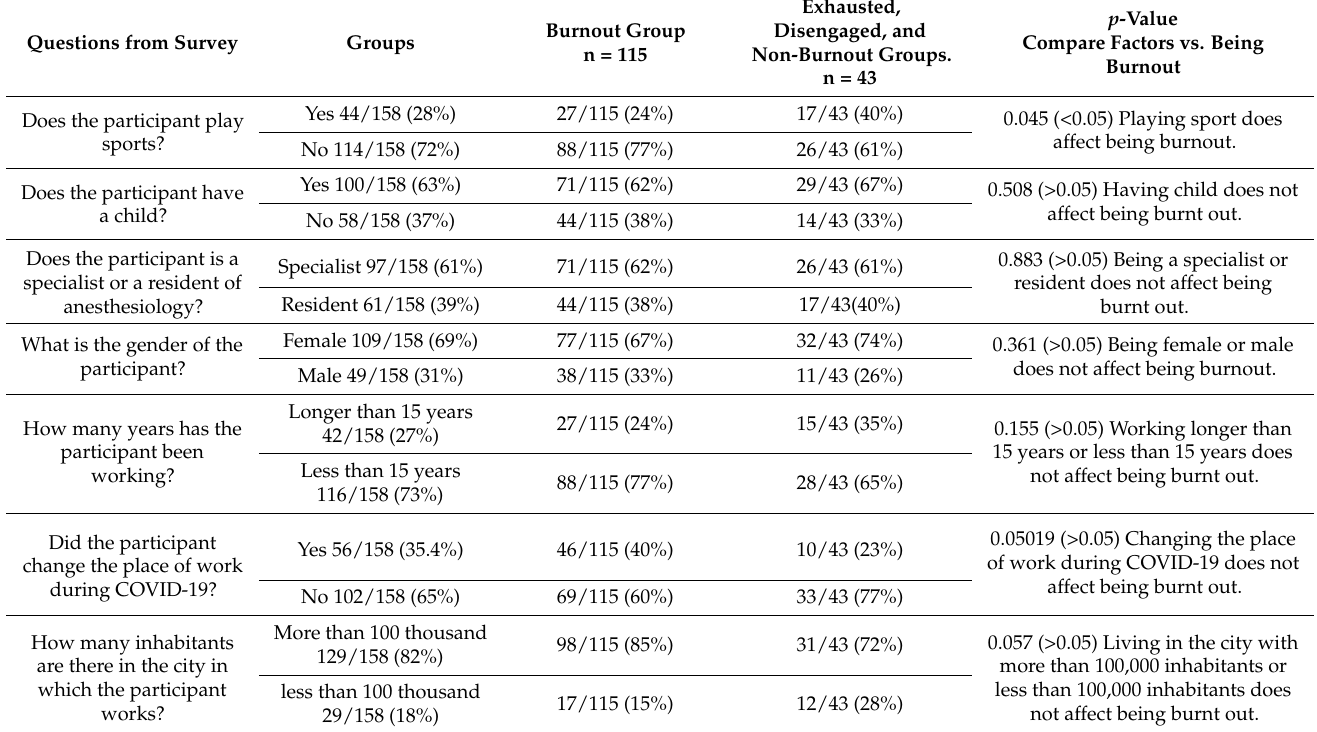
Table 2. Summary descriptive table compares the proportions of burnout vs. non-burnout accord- ing to the given questions . p -values were measured using a chi-square test. We measured whether factors, from the questions asked, statistically influenced being burned out in an anesthesiologist’s job. We considered whether playing sports, having a child, being a specialist or a resident, being a female or a male, the number of working hours, working less or more than 15 years, changing jobs during the COVID-19 pandemic, or living in a city of more or less than 100,000 people affected the risk of professional